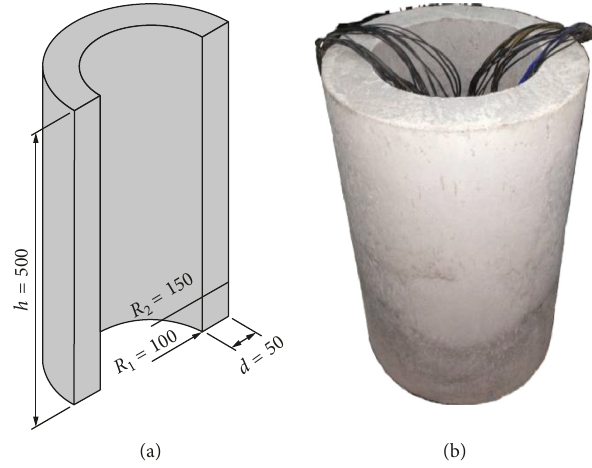
Figure 1: Size of the lining structure model (unit: mm).